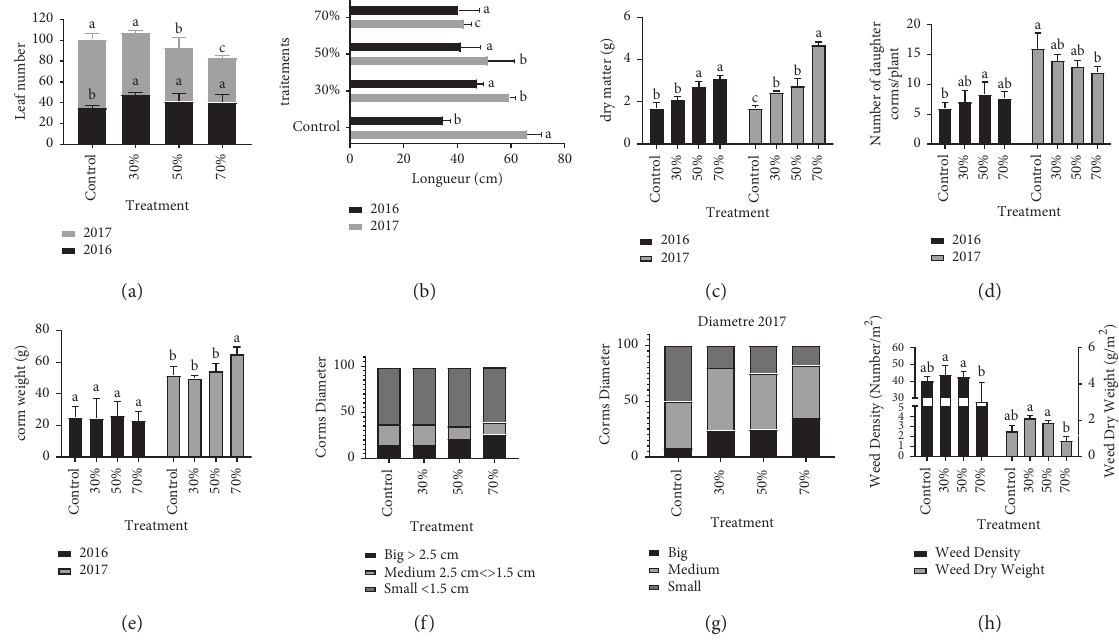
Figure 2: Effects of shading on the morphological parameters of the rudder. (a) Number of leaves; (b) leaf area; (c) dry matter; (d) number of thread corms; (e) weight of thread corms; (f) and (g) diameter of wire corms; and (h) density and dry weight of weeds associated with saffron cultivation. The data are the average of the five measurements made during the experiment. Different letters indicate significant differences between treatments ( p < 0.05). Table 2: Color coordinates of saffron leaves grown in full sun (0%) and 30%, 50%, and 70% shade.